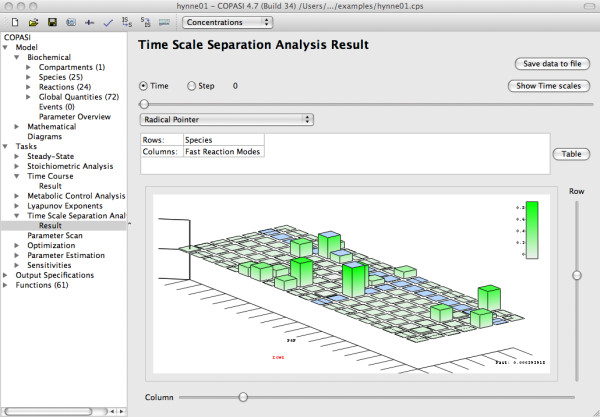
COPASI bar graph visualization of the Radical Pointers. Full glycolysis model of [16], [Glcx]0 = 24 at time t = 0. The 3D columns display the values of Radical Pointer as bars. One bar corresponds to one species (row) and one fast reaction mode (column).